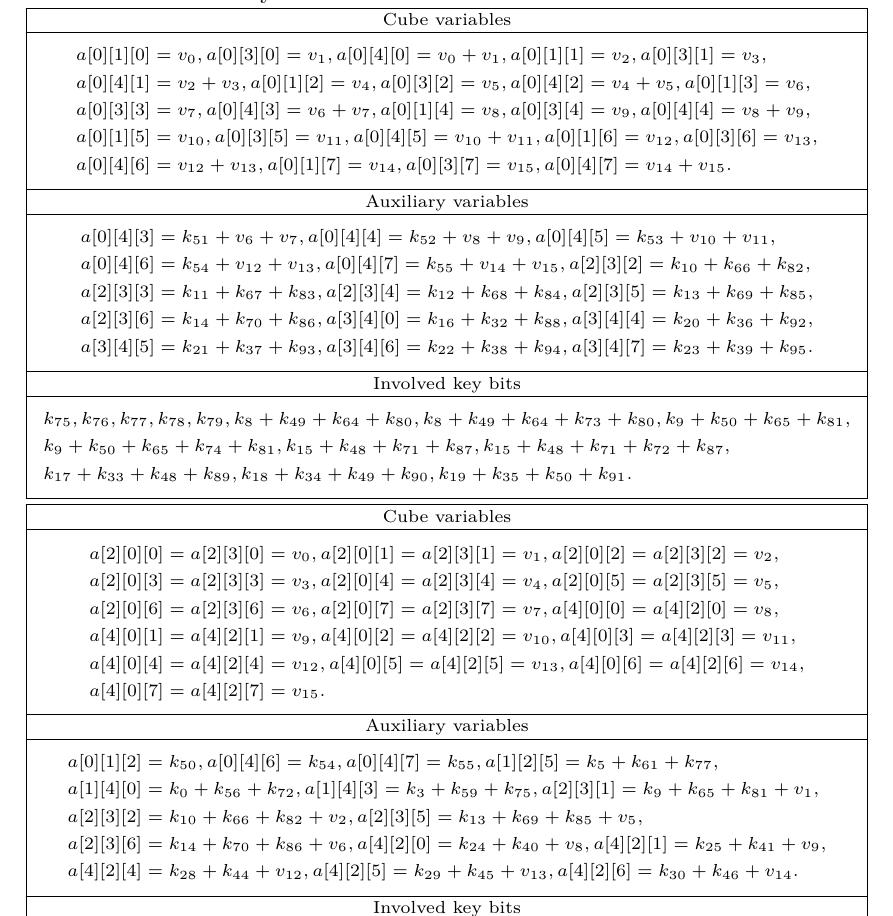
, n 0 ) are (15 , 14) and (9 , 13), respectively. The a i